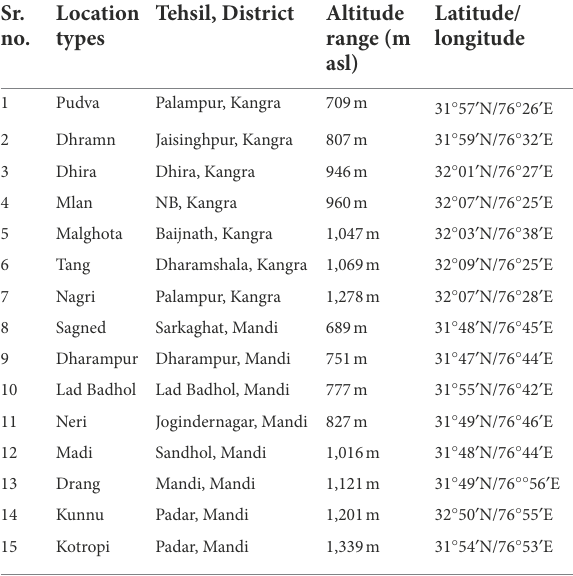
TABLE 1 Details of MK leaf collection sites from different location of Himachal Pradesh. Sr.